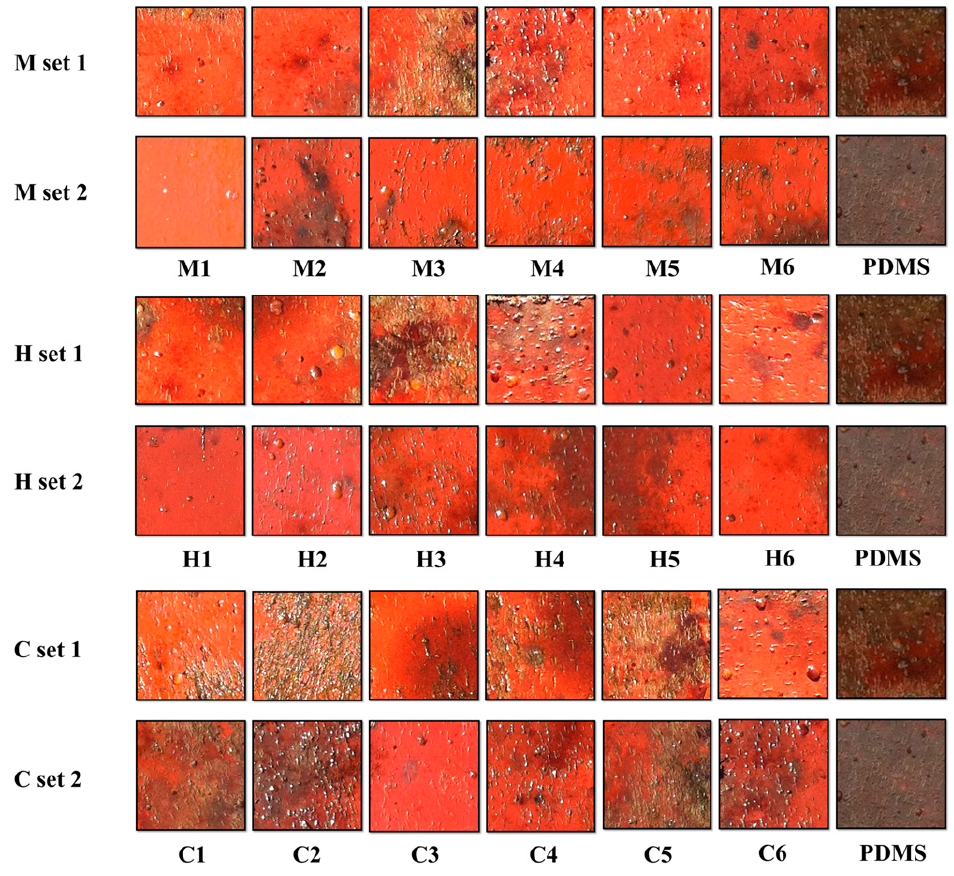
Figure 2. Appearances of various PDMS-based panels after static immersion for two months (April–June, 2015).